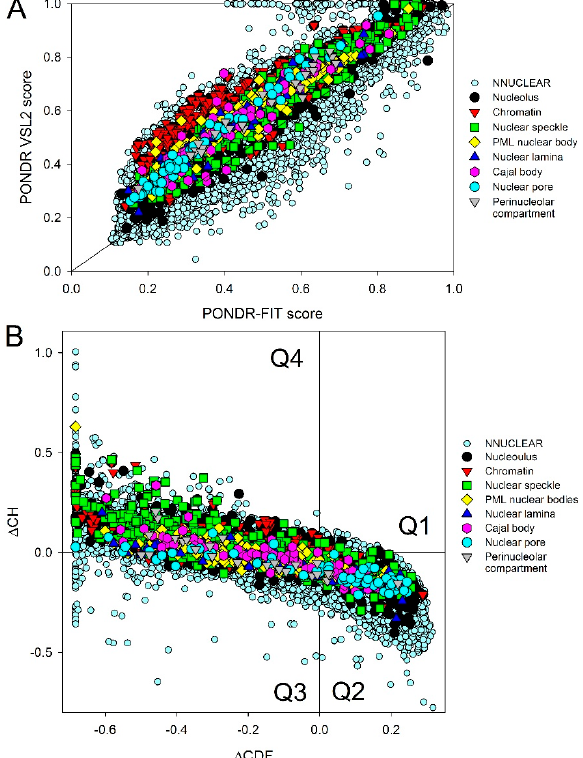
Figure 4. Abundance of intrinsic disorder in mouse proteins. ( A ) Per-proteins propensities for disorder (average of the corresponding per-residue propensities) evaluated by PONDR-FIT ( x -axis) and by PONDR ® VSL2 (85) ( y -axis) for the non-nuclear proteins from the NNUCLEAR dataset and proteins in the considered intra-nuclear compartment from the NUCLEAR ap dataset; ( B ) Evaluation of intrinsic disorder in mouse proteins (NNUCLEAR and NUCLEAR ap datasets) by CH-CDF analysis. In this figure, each point’s coordinates were computed as follows: the y -axis represents the distance of the protein in the CH-plot from the boundary, while the x -axis shows the average distance between the CDF boundary and the respective CDF curve. The figure is split into four quadrants/sections, with each quadrant representing a different family of predictions. Q1 shows proteins predicted to be ordered by CDFs but disordered by CH-plots. Q2 displays proteins that are completely ordered. Q3 shows proteins that were predicted as compact by CH-plots but disordered by CDFs ( i.e. , hybrid proteins or putative molten globules). Finally, Q4 portrays proteins which both methods predicted to be disordered. Proteins found in different sub-nuclear compartments are indicated by differently colored symbols. In both plots, mouse non-nuclear proteins are shown by small light blue circles. Proteins in different nuclear compartments are indicated as follows: nucleolus —black circles; chromatin—red inverted triangles; nuclear speckles—green squares; PML nuclear bodies—yellow diamonds; nuclear lamina—blue triangles; Cajal bodies—pink hexagons; nuclear pore—cyan circles; and perinucleolar compartment—gray inverted triangles.